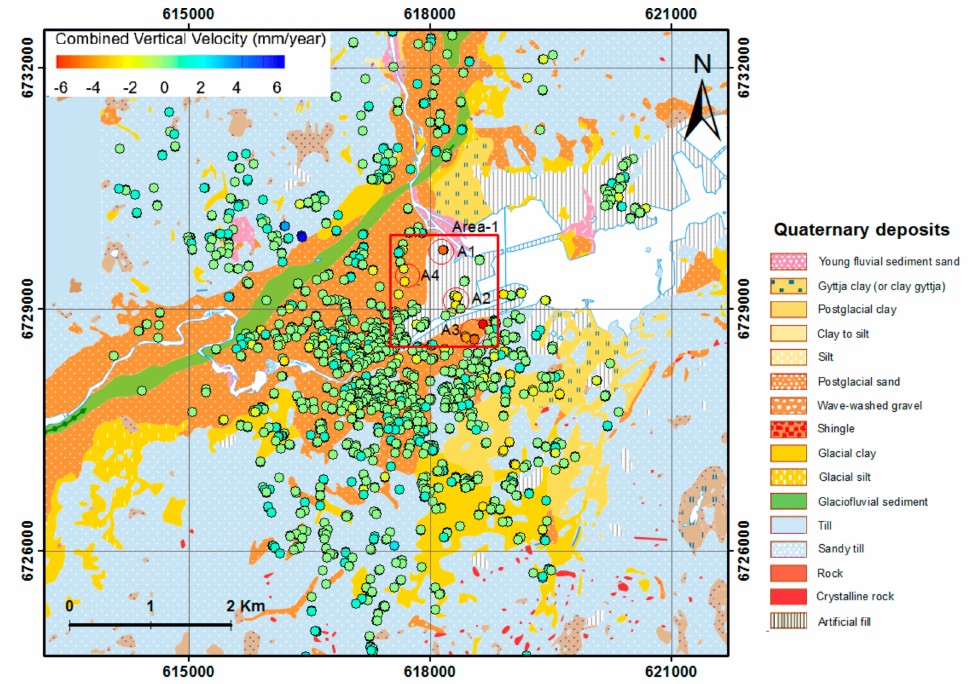
Figure 7. The vertical displacement rate of the combined ascending and descending PS points overlaid on the quaternary deposits map of the city of Gävle. Negative values denote for subsidence, while the positive denotes for uplift. Base map: Quaternary deposit © Geological Survey of Sweden (SGU). Coordinate system: SWEREF 99. Unit: mm /